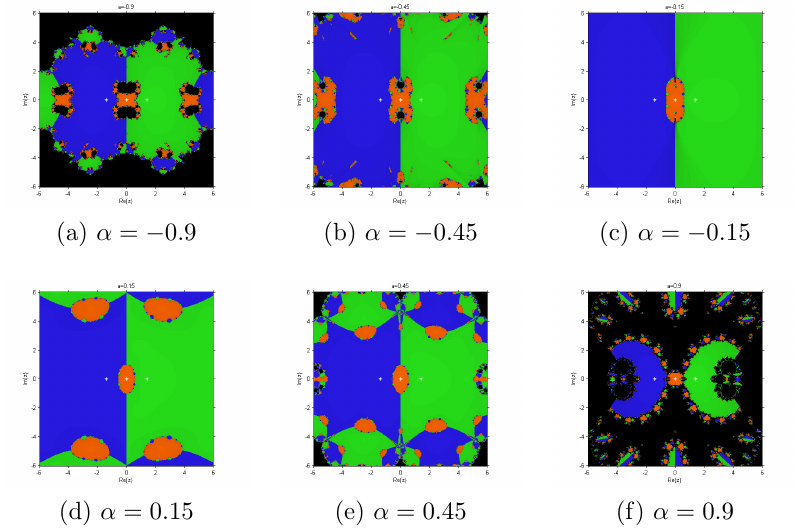
Figure 2. Dynamical planes of some members of PM class on f ( x ) = arctan( x ) − 2 x